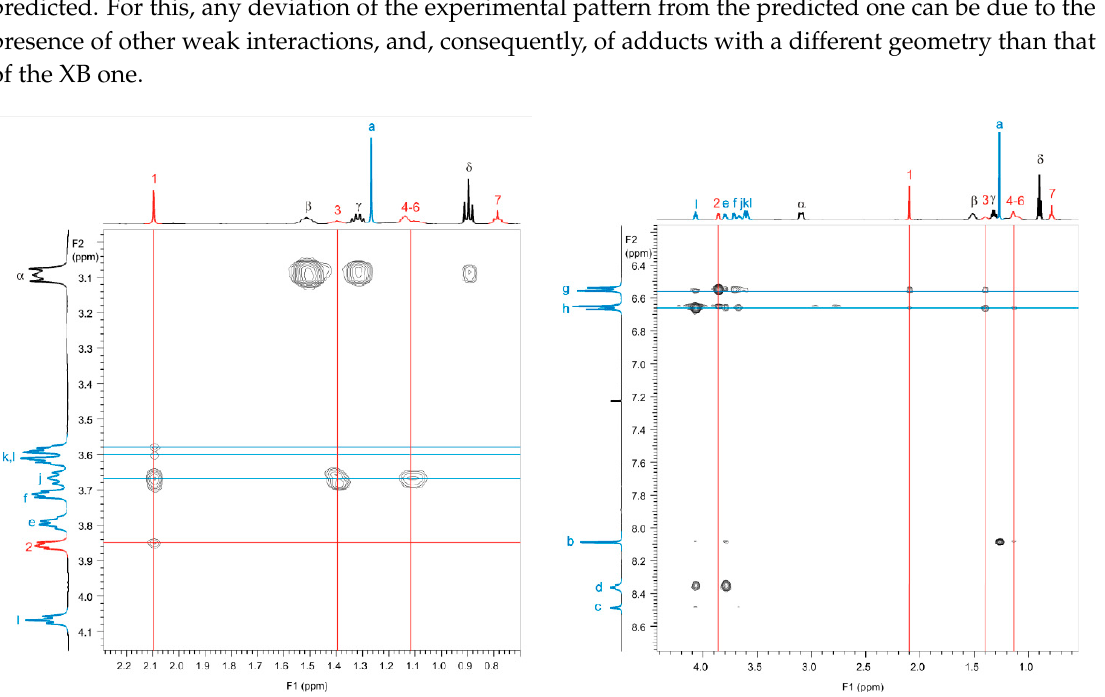
Figure 6. Reproduced from reference [87]. Through-space coupling between protons on imidazolium chloride 2d and the posterior polyether protons of 1 (left) and between protons on imidazolium chloride 2d and the hydroquinone protons of 1 (right). Blue and red peaks refer to compound 1 and 2d , respectively. Labels in greek refer to the tetrabutylammonium cation. Copyright 2010 Wiley-VCH Verlag GmbH & Co. KGaA.